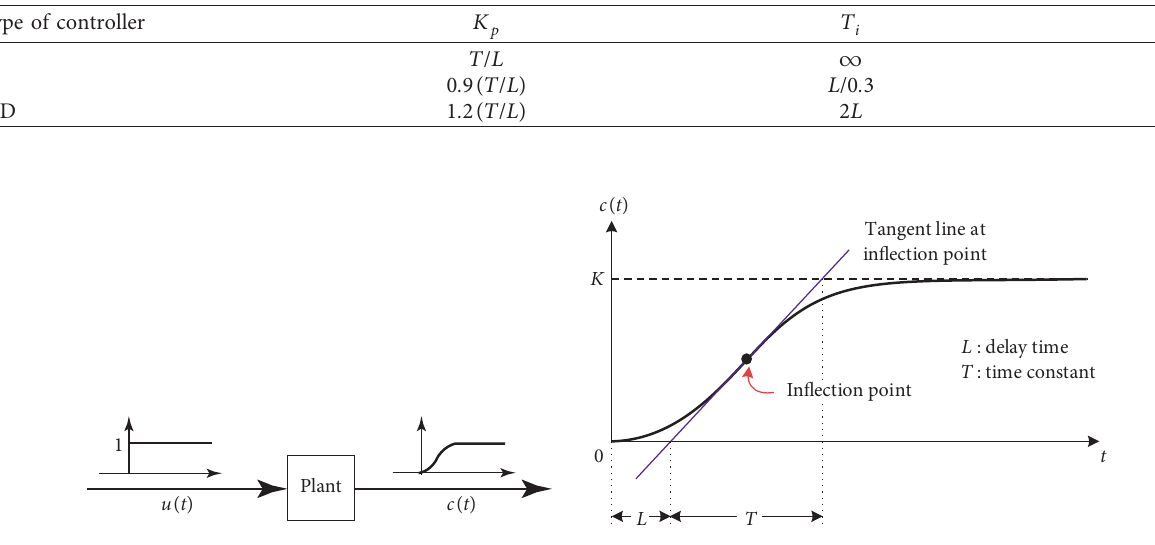
Figure 3: Unit-step response of a plant